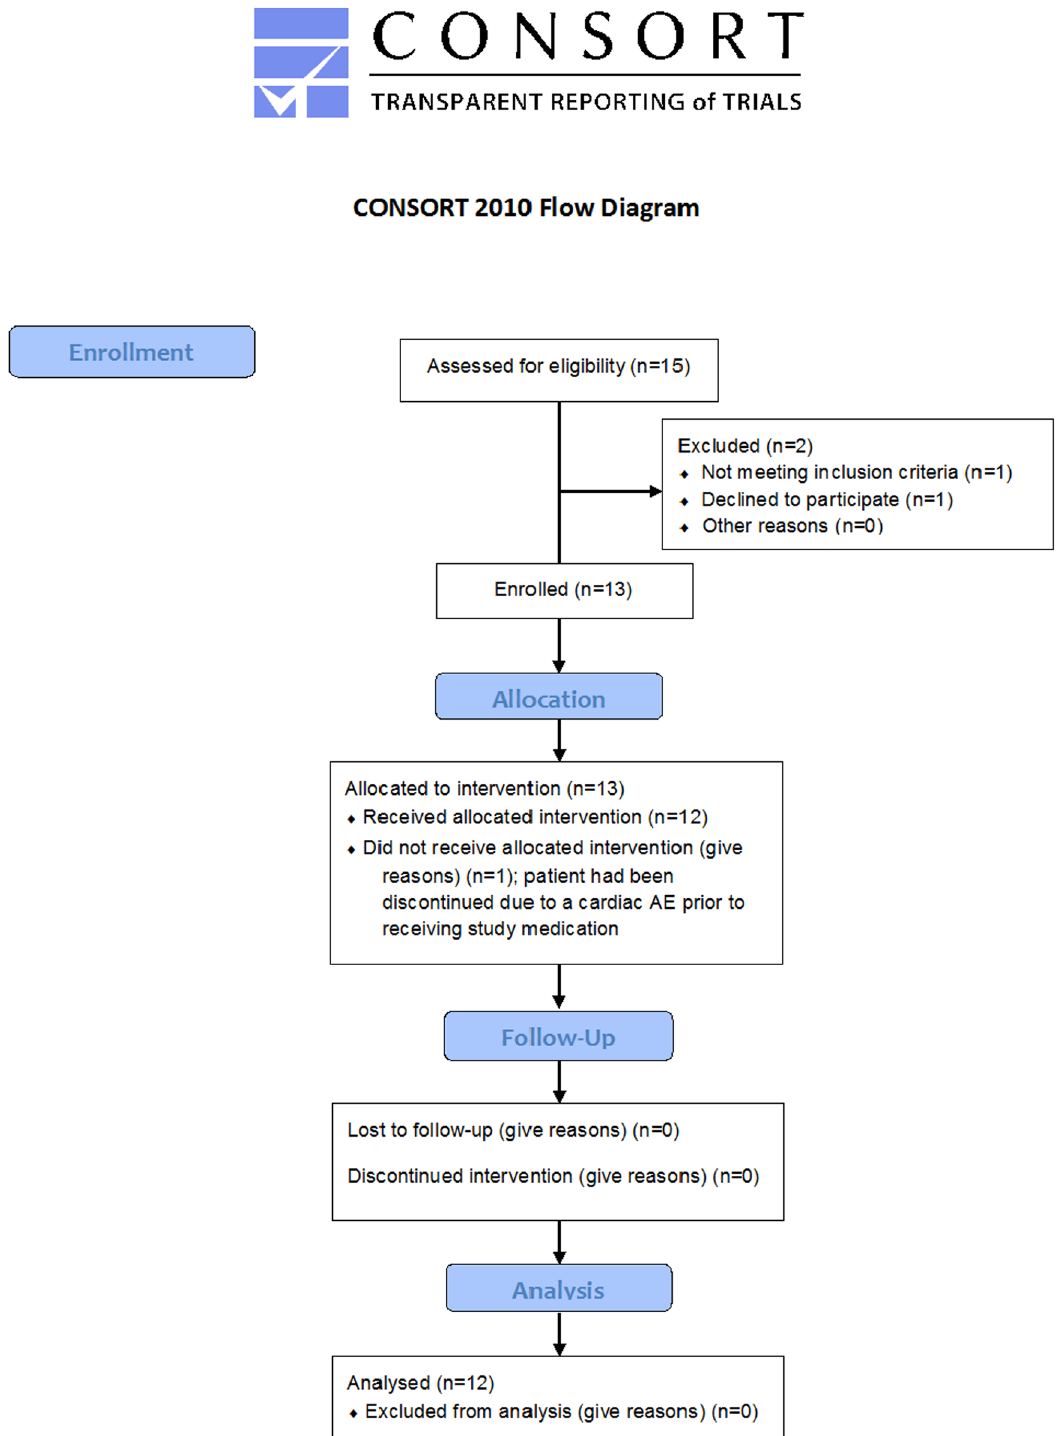
Fig 1. CONSORT flow diagram. Overview indicatesthe patient allocation.